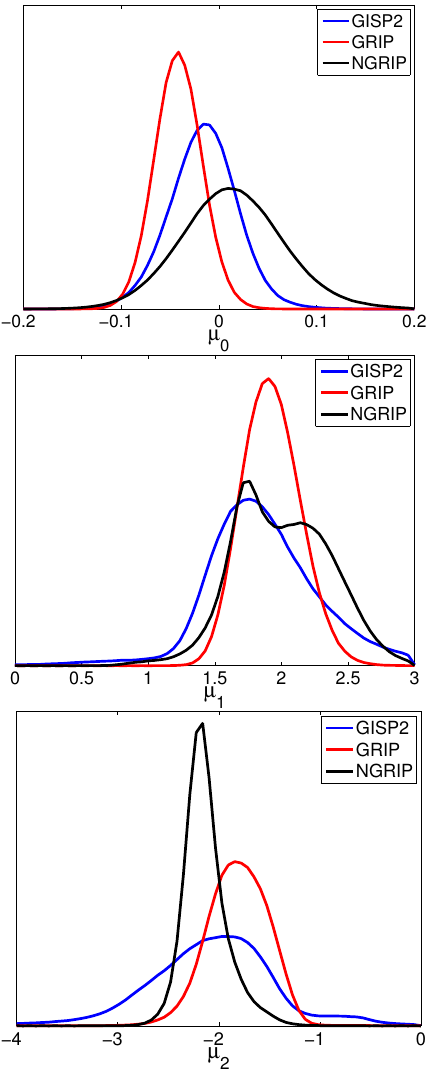
Fig. 6: Posterior distributions of forcing µ for three hidden states. There is significant agreement between NGRIP and GRIP for all three states.